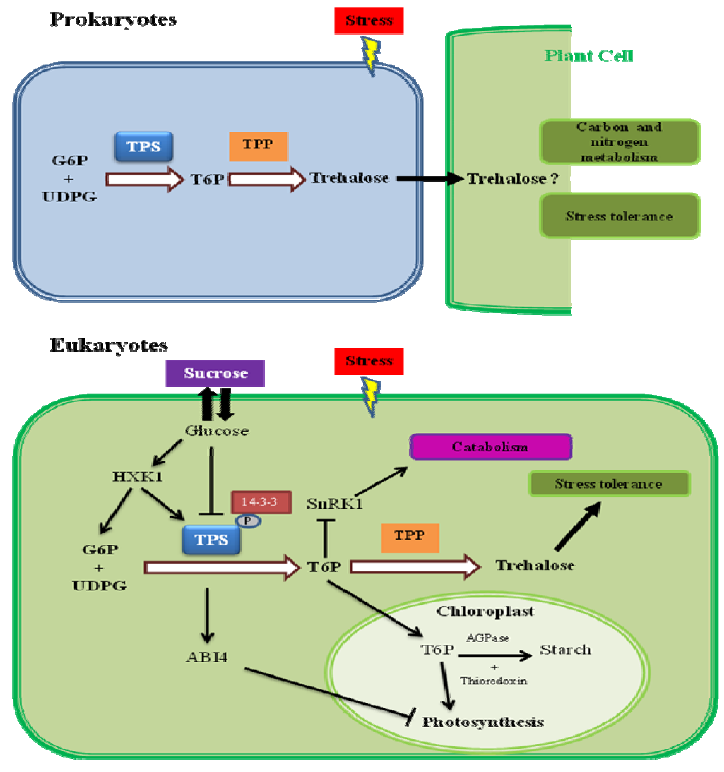
Figure 3. The role of trehalose pathway in prokaryotes and eukaryotes. Trehalose in prokaryotes dramatically accumulates in osmotic or thermal stress conditions; it can signal from the bacteria to the plant cell stress tolerance and nitrogen and carbon metabolism. In plants, trehalose 6-phosphate (T6P) plays a central role regulating sugar metabolism and plant development. Glucose and trehalose are also important keys to several signaling and regulatory pathways and integrate external cues to adapt cells to abiotic stress, growth and development. It seems that TPS1 and ABI4 are part of the HXK1 signaling pathway. Other molecular actors in this network are the 14-3-3 proteins, which are known to interact with phosphoserine in diverse proteins including TPS; and SnRK1, which signals catabolism in starvation conditions, and is countered by T6P to induce anabolism. Thus, an important role of the trehalose biosynthesis pathway in higher plants would be the synthesis of small amounts of T6P and/or trehalose signaling molecules rather than accumulation of this latter as an osmoprotective